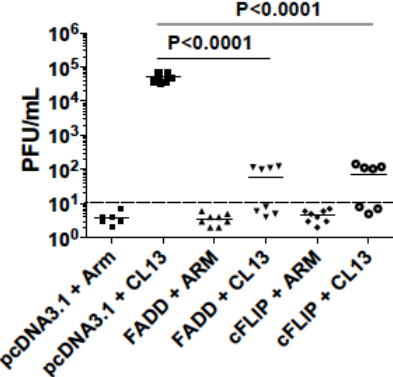
Figure 8. LCMV-CL13 persistence is less frequent in mice given FADD or cFLIP plasmids. On day0, C57BL/6 mice were electroporated with either pcDNA3.1 (control) or plasmids expressing FADD, or cFLIP. On day7, mice were infected with LCMV-Armstrong (Arm) or LCMV-Clone 13 (CL13), and on day 16, mice were sacrificed and assessed for CMI and viremia as described in Methods. The limit of detection for simple plaque assays is 10 2 PFU/mL and the limit of detection for the 2-step assays is 10 PFU/mL, so mice with less than 10 PFU/mL are considered to have “cleared” the virus. Data were representative of two repeated